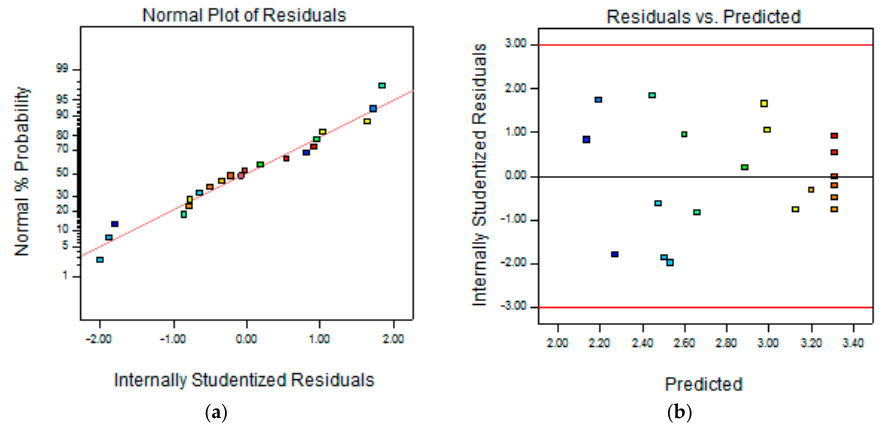
Figure 2. ( a ) Normal probability of internally studentized residuals; ( b ) Plot of internally studentized residuals vs. predicted response.